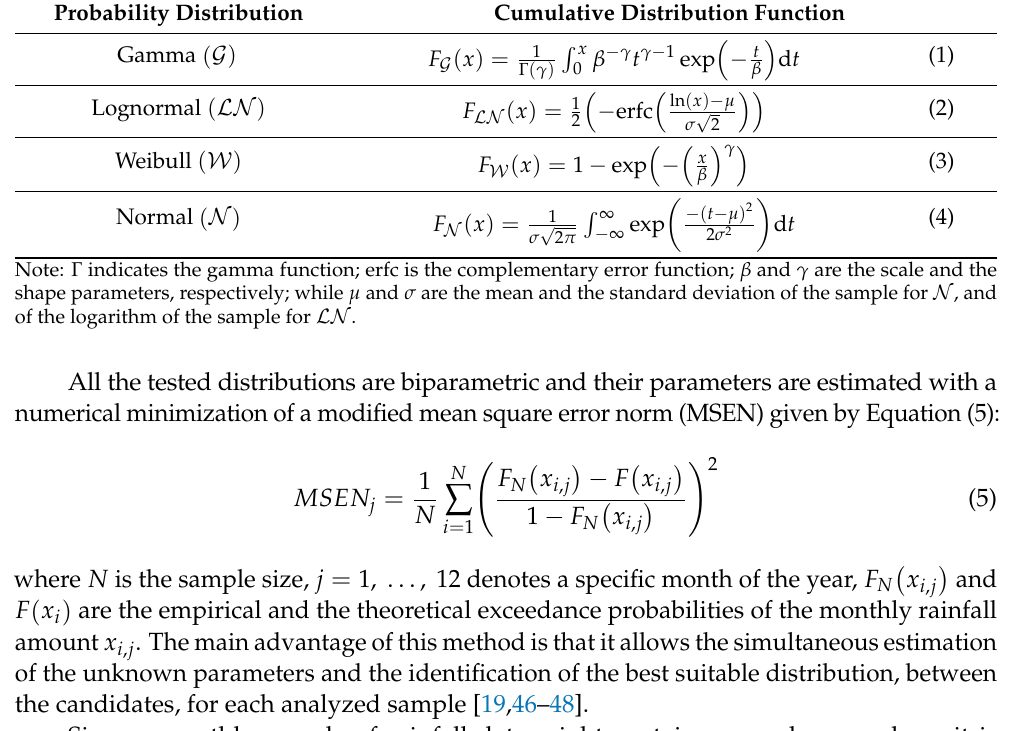
Table 3. Cumulative distribution functions of the four candidates. Probability Distribution Cumulative Distribution